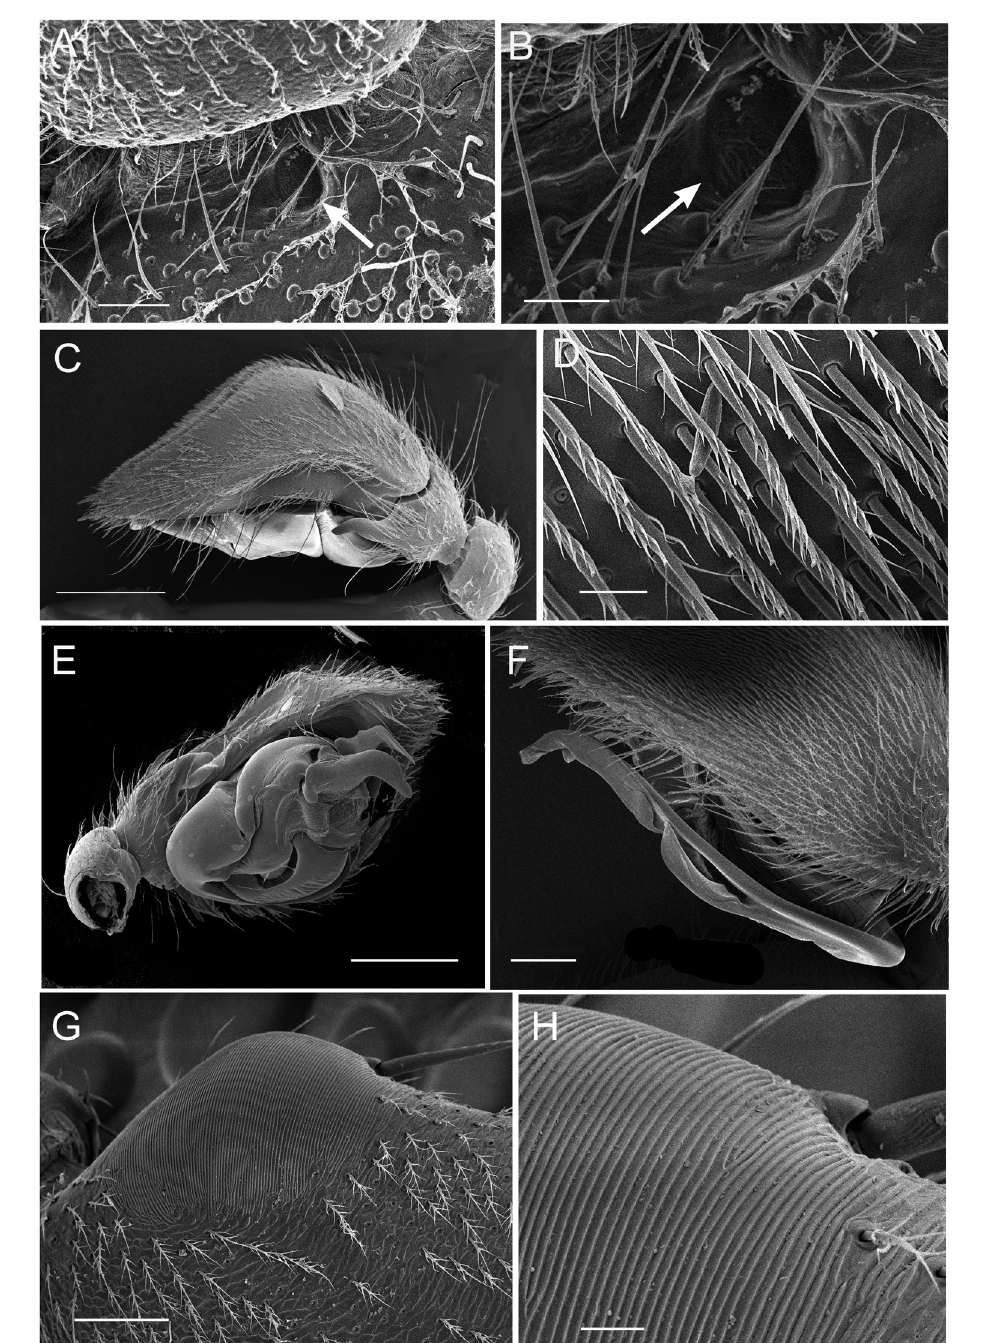
Fig. 4. Scanning electron micrographs. A–F. Cambonilla securicula Jocqué gen. et sp. nov., male paratype (RBINS IG 33.889/005). G–I . Cambonilla symphonia Jocqué & Henrard gen. et sp. nov., male paratype (RBINS IG 33.889/009). Scanning electron micrographs. A . Sternal depression. B . As preceding, detail. C . Male palp, lateral view. D . Chemosensitive setae on cymbium, lateral view. E . Male palp, ventral view. F . Embolus with bifurcation, prolateral view. G . Stridulating file on base of F I, prolateral view. H . As preceding, detail. Scale bars: A, G = 0.1 mm; B = 50 µm; C, E = 0.5 mm; D, H = 20 µm; E = 0.5 mm; F = 0.2 mm; G = 0.1 mm; H = 20